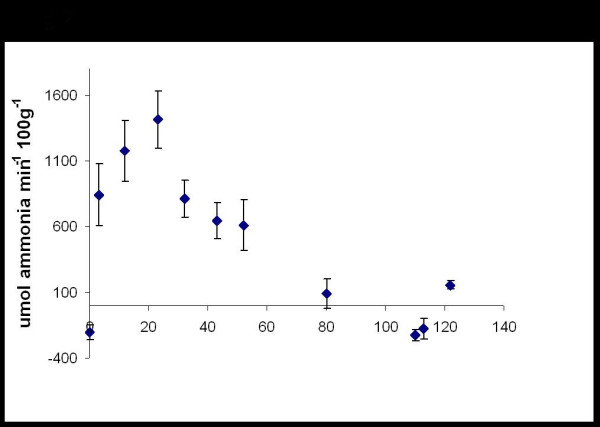
Represents muscle ammonia efflux measured during rest and during the 3rd to fourth minute of contraction (this is when a venous blood sample was obtained) and during the first 2 minutes of recovery. Peak ammonia efflux from the muscle occurred during the 2nd period of muscle contraction. During the fourth period of contraction there was no measurable release of ammonia from the muscle tissue. The black bars at the top of the graph represent the period of muscle stimulation.